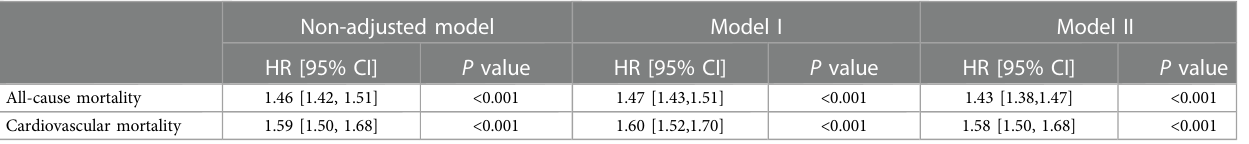
TABLE 3 Cox regression analysis on the association between ePWV and All-cause mortality and cardiovascular